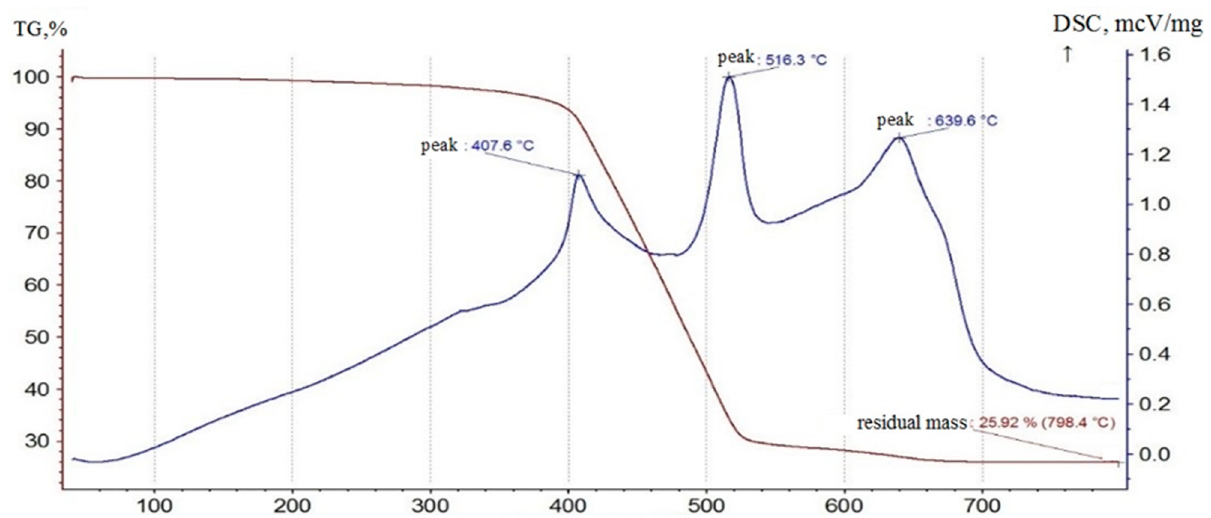
Figure 9. DSC of nano-modified elastomer. The heating process of the nanomodified elastomer clearly proceeds without any changes at temperatures up to 200 °C. Further heating up to 400 °C is accompanied by a phase transition.